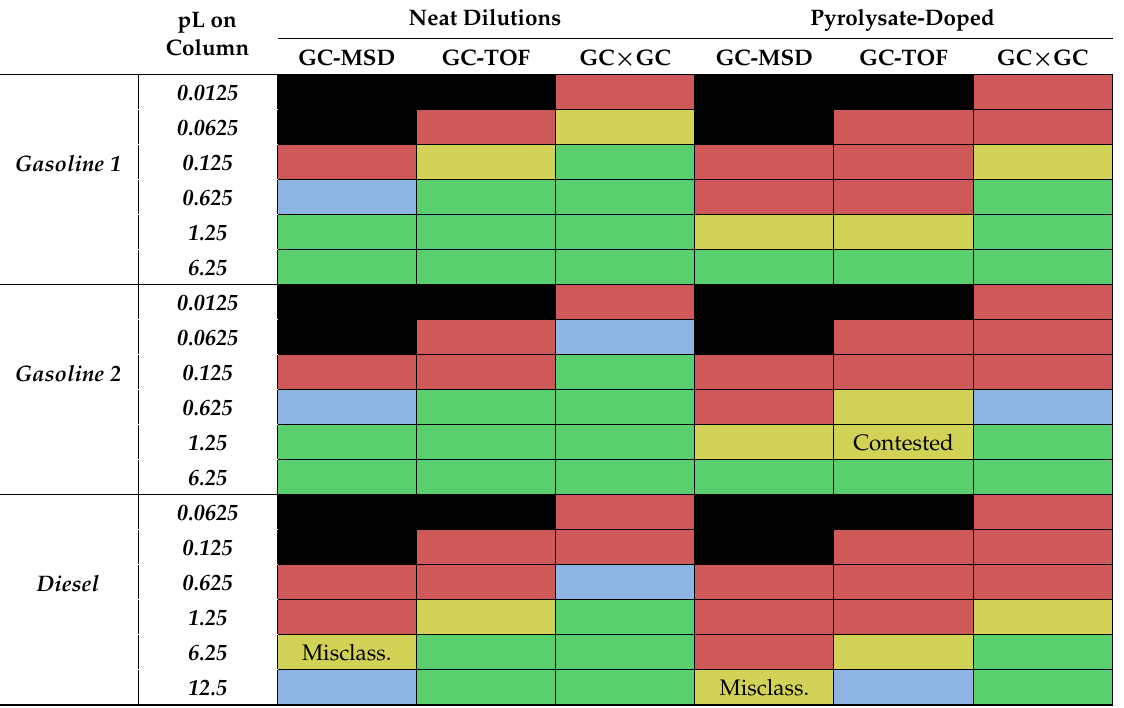
Table 4. Color-coded results of the